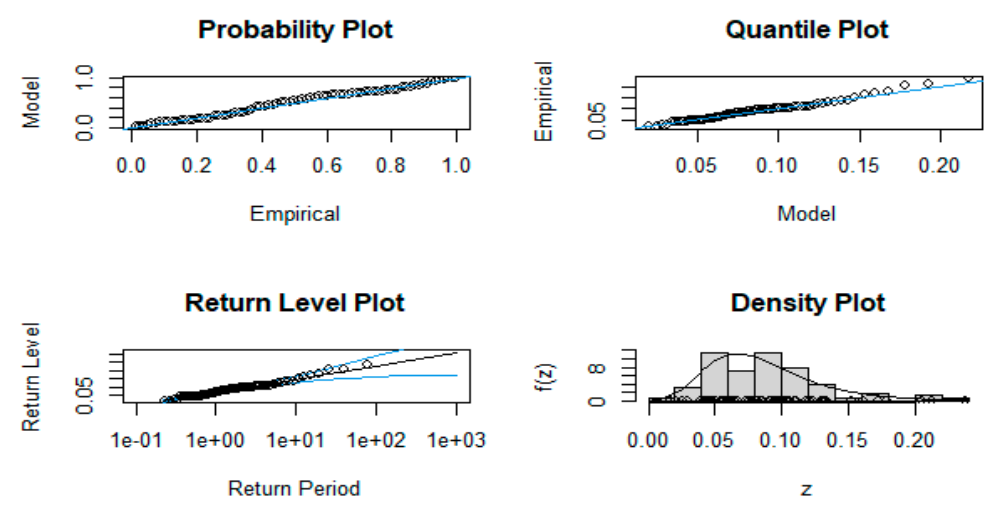
Figure 5. Model diagnostics for the maxima of the BTC/USD (upper tail, gains or maxima returns).